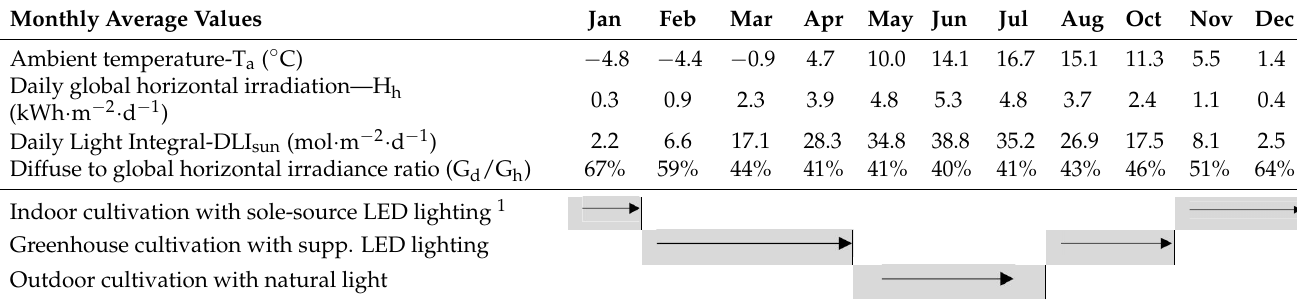
Table 3. Summary of monthly values for the year-round cultivation concept in Borlänge, Sweden. Monthly Average